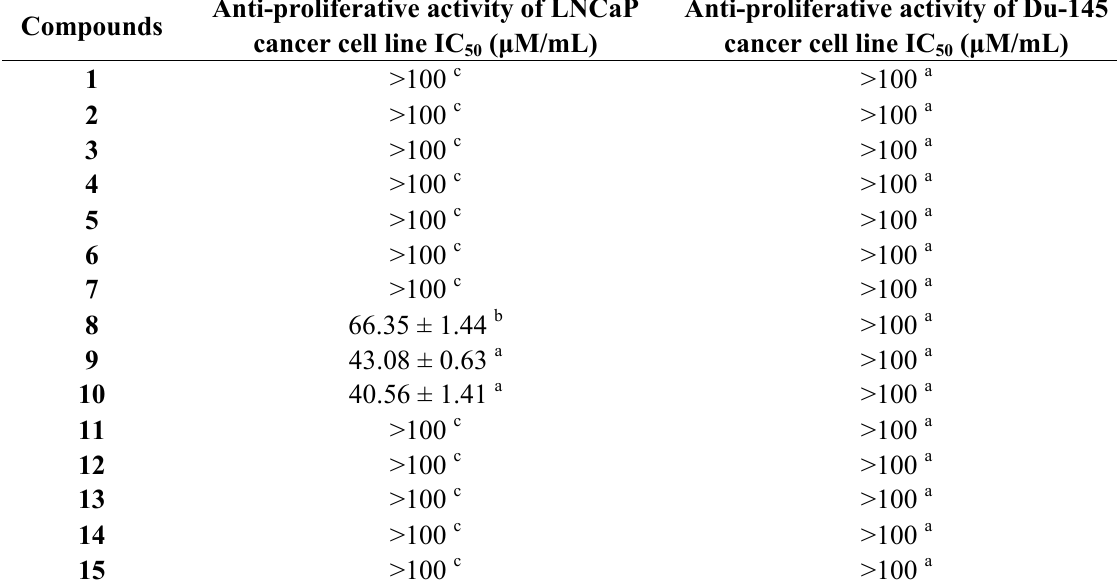
Values represent means ± S.D . of three determinations. Values bearing different superscripts in the same column are significantly different ( p <